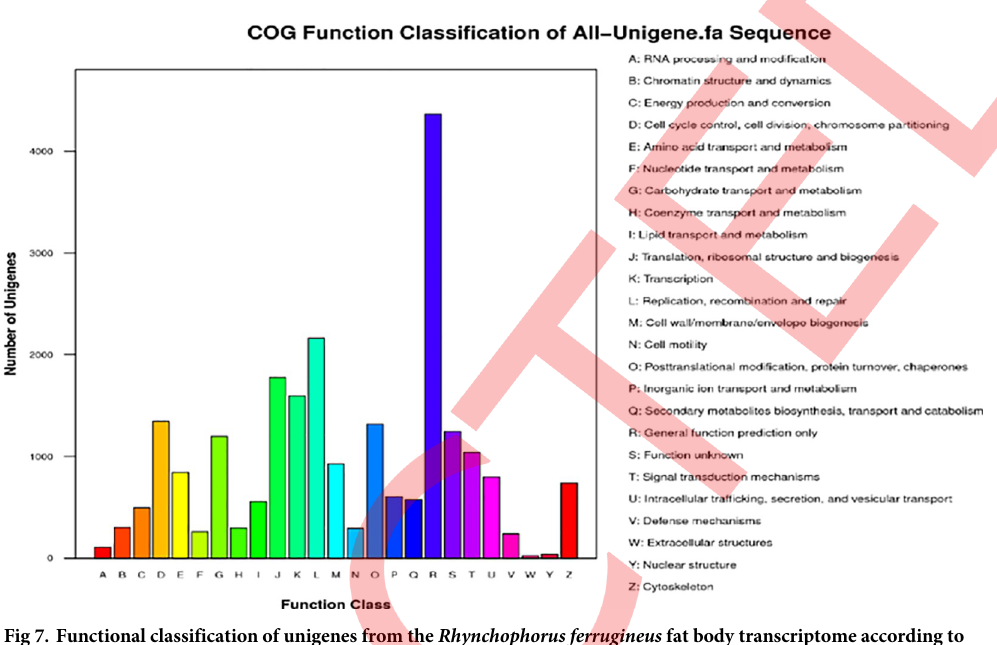
Fig 7. Functional classification of unigenes from the Rhynchophorus ferrugineus fat body transcriptome according to COG criteria.